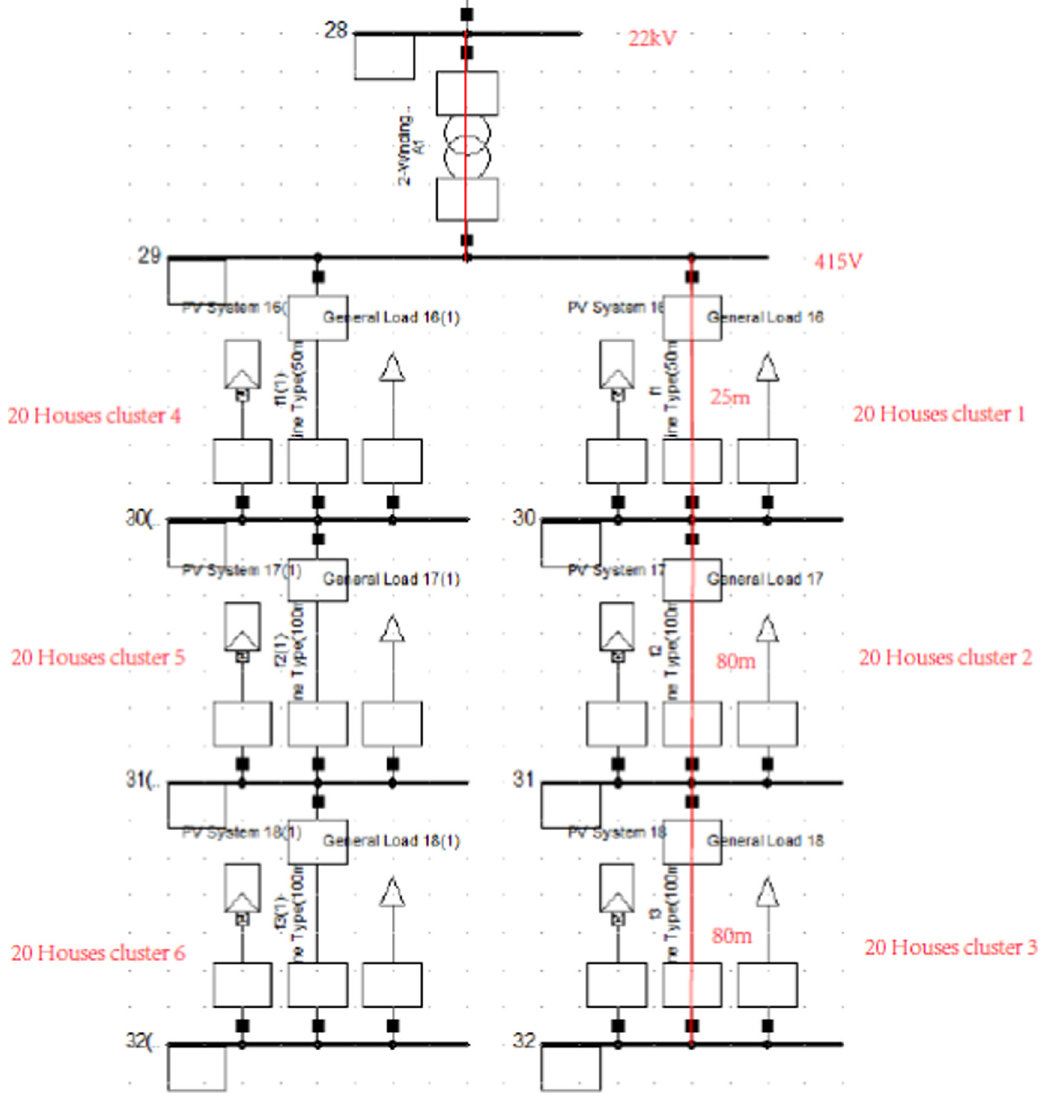
Fig. 2. Highlighted LV feeder of Figure 1